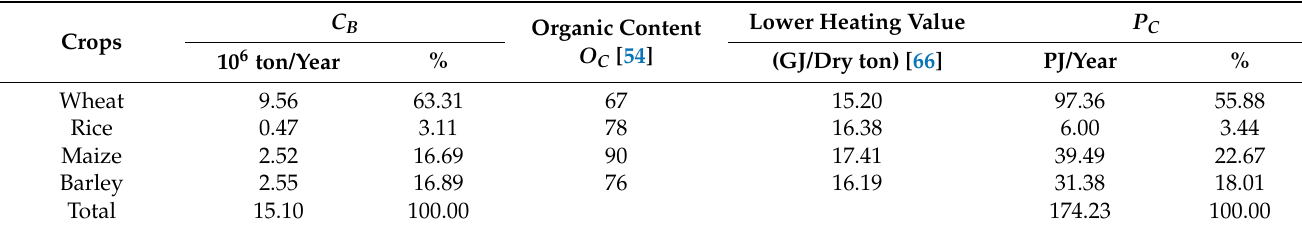
Table 4. Energy potential of different crop residues available in Kazakhstan.